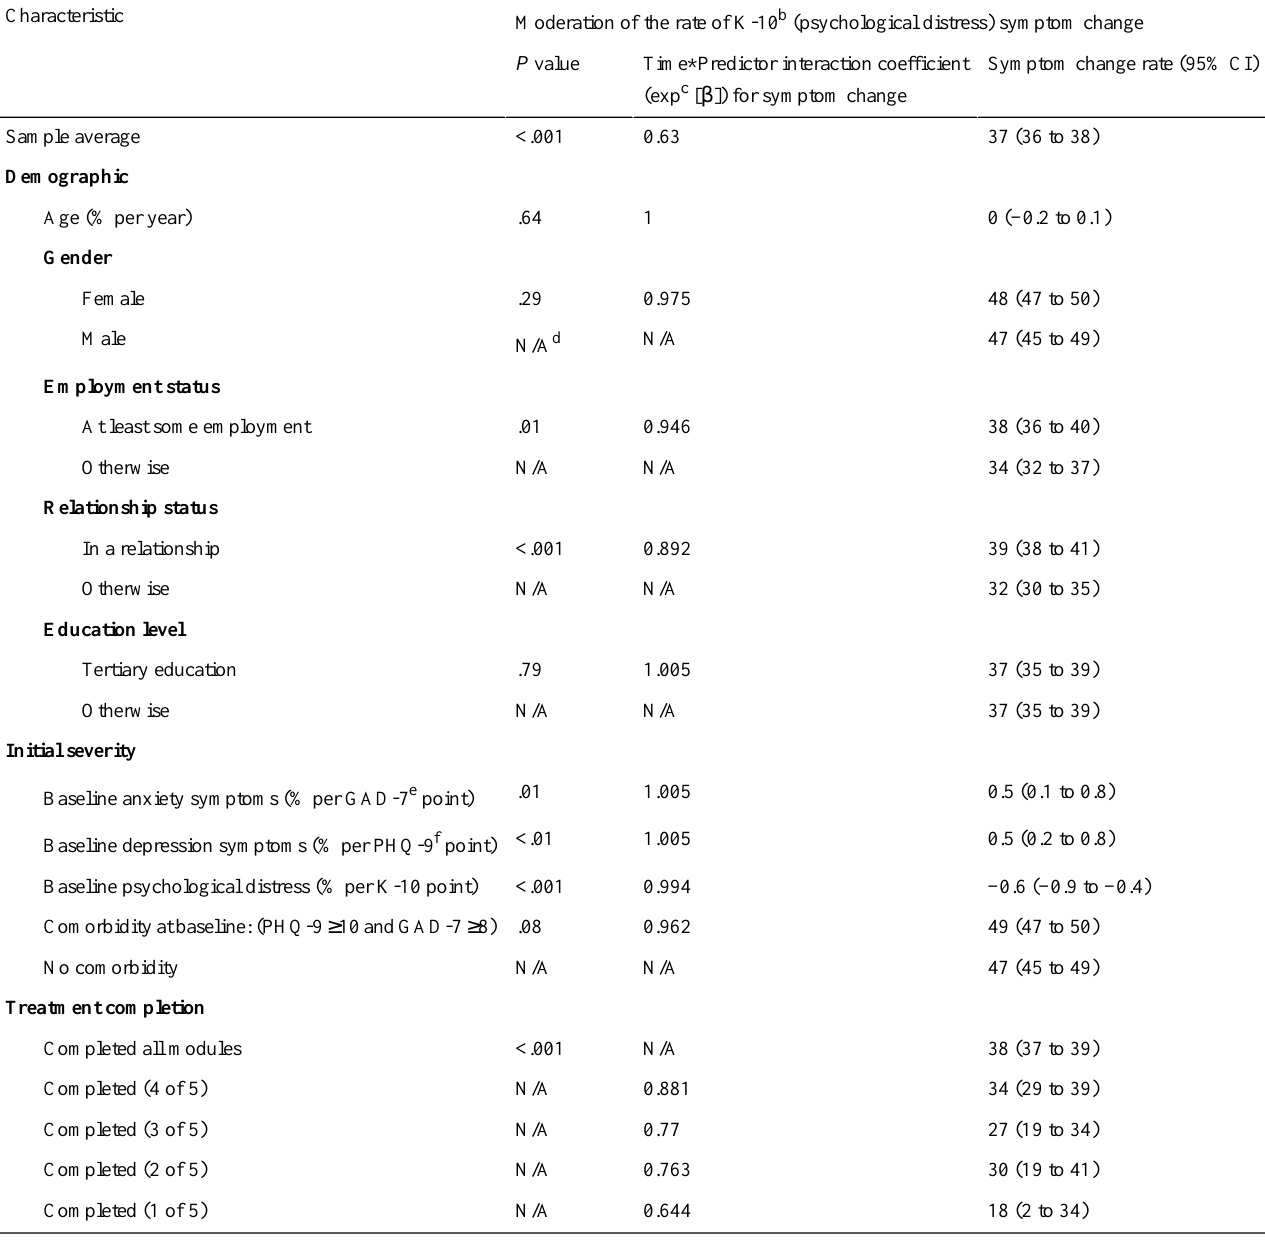
Table 7. Longitudinal estimates of average psychological distress (Kessler-10) symptom moderation.